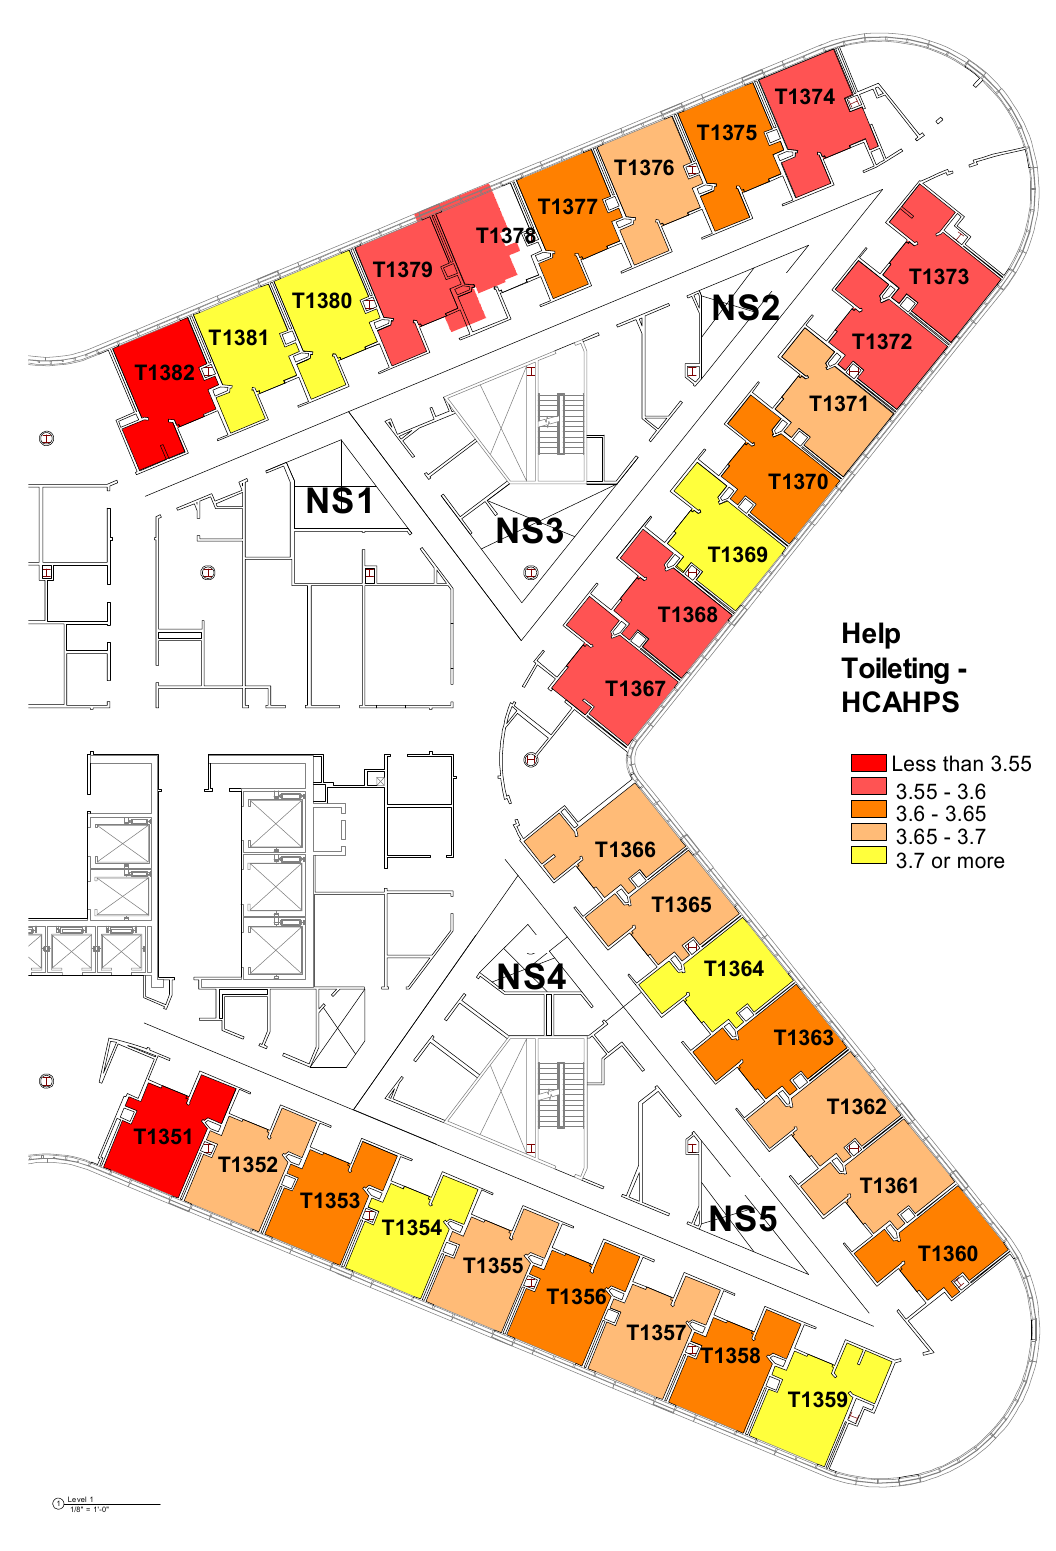
Figure 5. Heat map of room-level patients’ perception of “help toileting as soon as you wanted” based on HCAHPS survey.